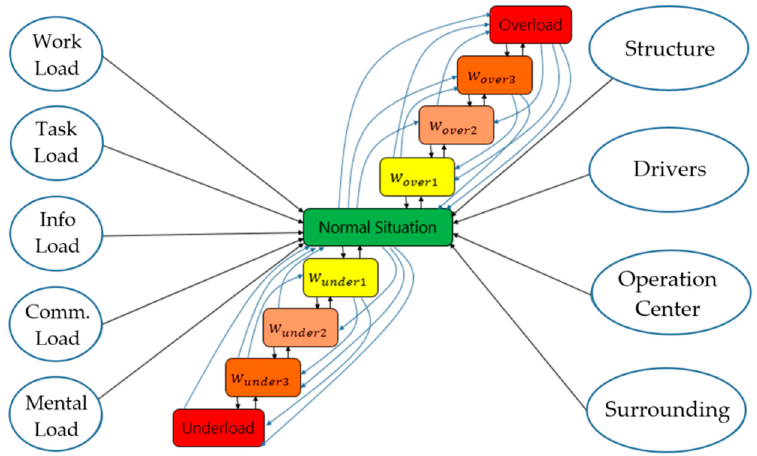
Figure 11. Stochastic load model of flight risk .